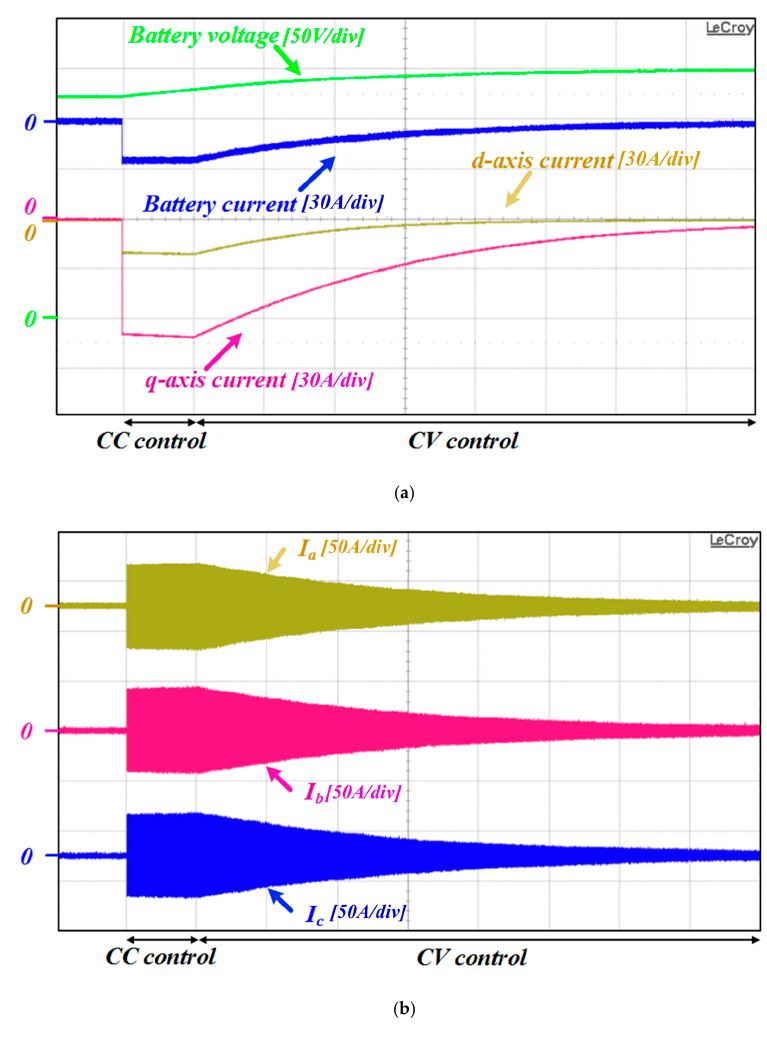
Figure 12. Experimental results of the CC-CV control at 4800 rpm (charging current: 28 A, charging voltage: 250 V). ( a ) dq-axis currents and battery voltage/current; ( b ) phase currents. Electronics 2019 , 8 , 1126